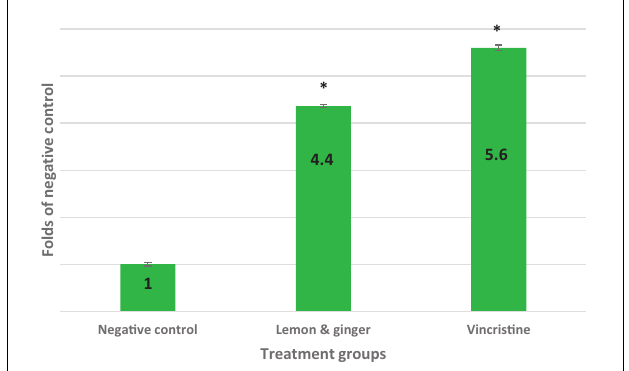
FIGURE 3 | Folds of caspase-3 activity and apoptosis induction in IC 50 concentrations of vincristine (0.025 mg/ml), lemon, and ginger combination (3.5 mg/ml) in MDA-MB231 cell line. *Significant values ( P -value = 0.05).